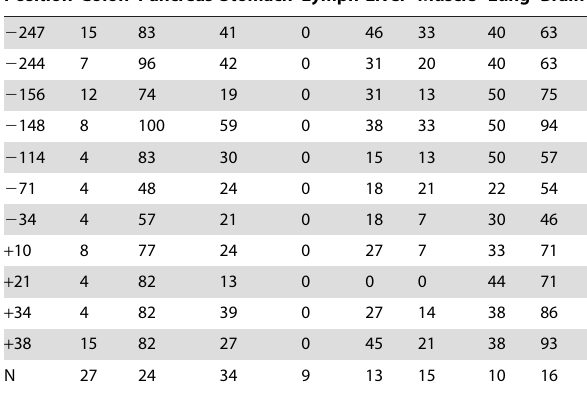
*Percent of methylation on each CpG site was evaluated by bisulfite sequencing. Position refers to that of the CpG dinucleotide relatively to transcription start site (Fig. 1), and N refers to number of sequenced clones.